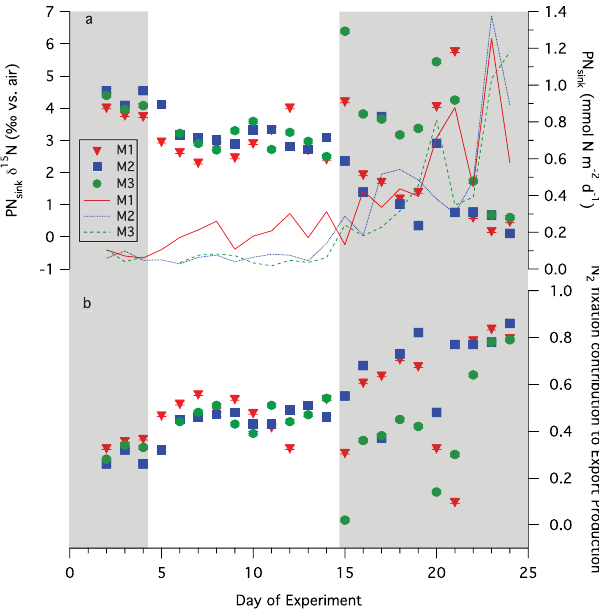
Figure 2. VAHINE PN sink mass flux in M1 (red solid line), M2 (blue dotted line), and M3 (green dashed line), and PN sink δ 15 N in M1 (red filled inverted triangles), M2 (blue filled squares), and M3 (green filled circles) (a) and the corresponding contribution of N 2 fixation to export production (b). Shaded regions indicate P0 (days 1 through 4) and P2 (days 15 through 23), with the unshaded region in between indicating P1 (days 5 through 14). PN sink δ 15 N error bars represent an average measurement SD of ± 0.06‰, and error bars for the fractional contribution of N 2 fixation to the PN sink flux reflect the ± 0.06‰ range associated with the PN sink δ 15 N mea-